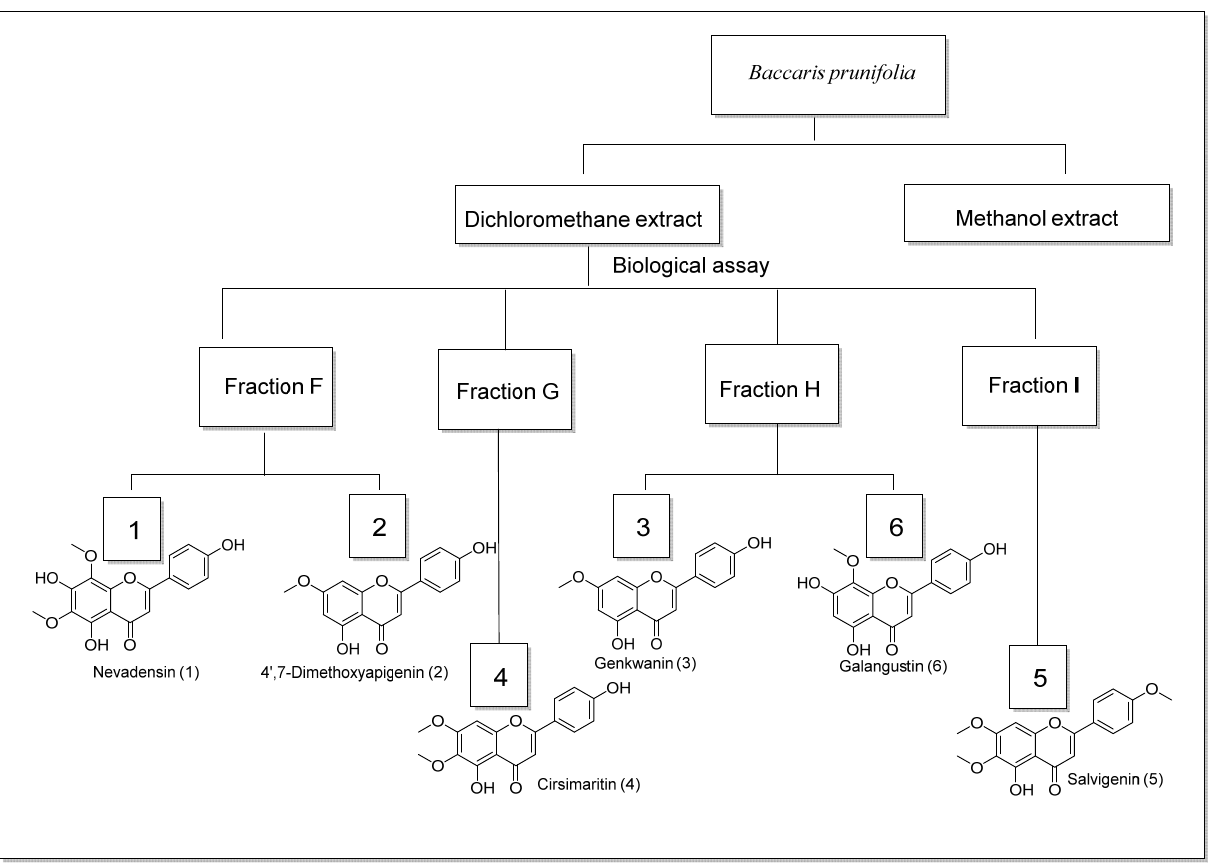
Figure 1. Scheme of the bio-guided isolated compounds from Baccharis prunifolia .